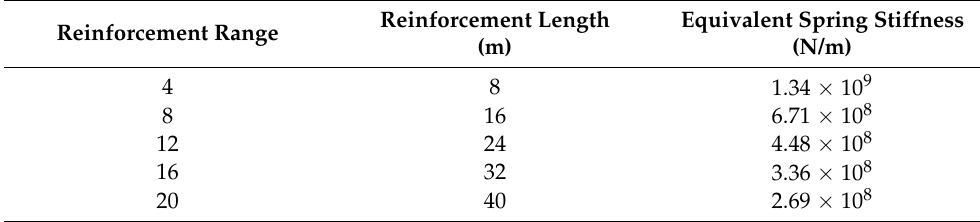
Table 3. Equivalent spring stiffness of steel channel under different reinforcement ranges. Reinforcement